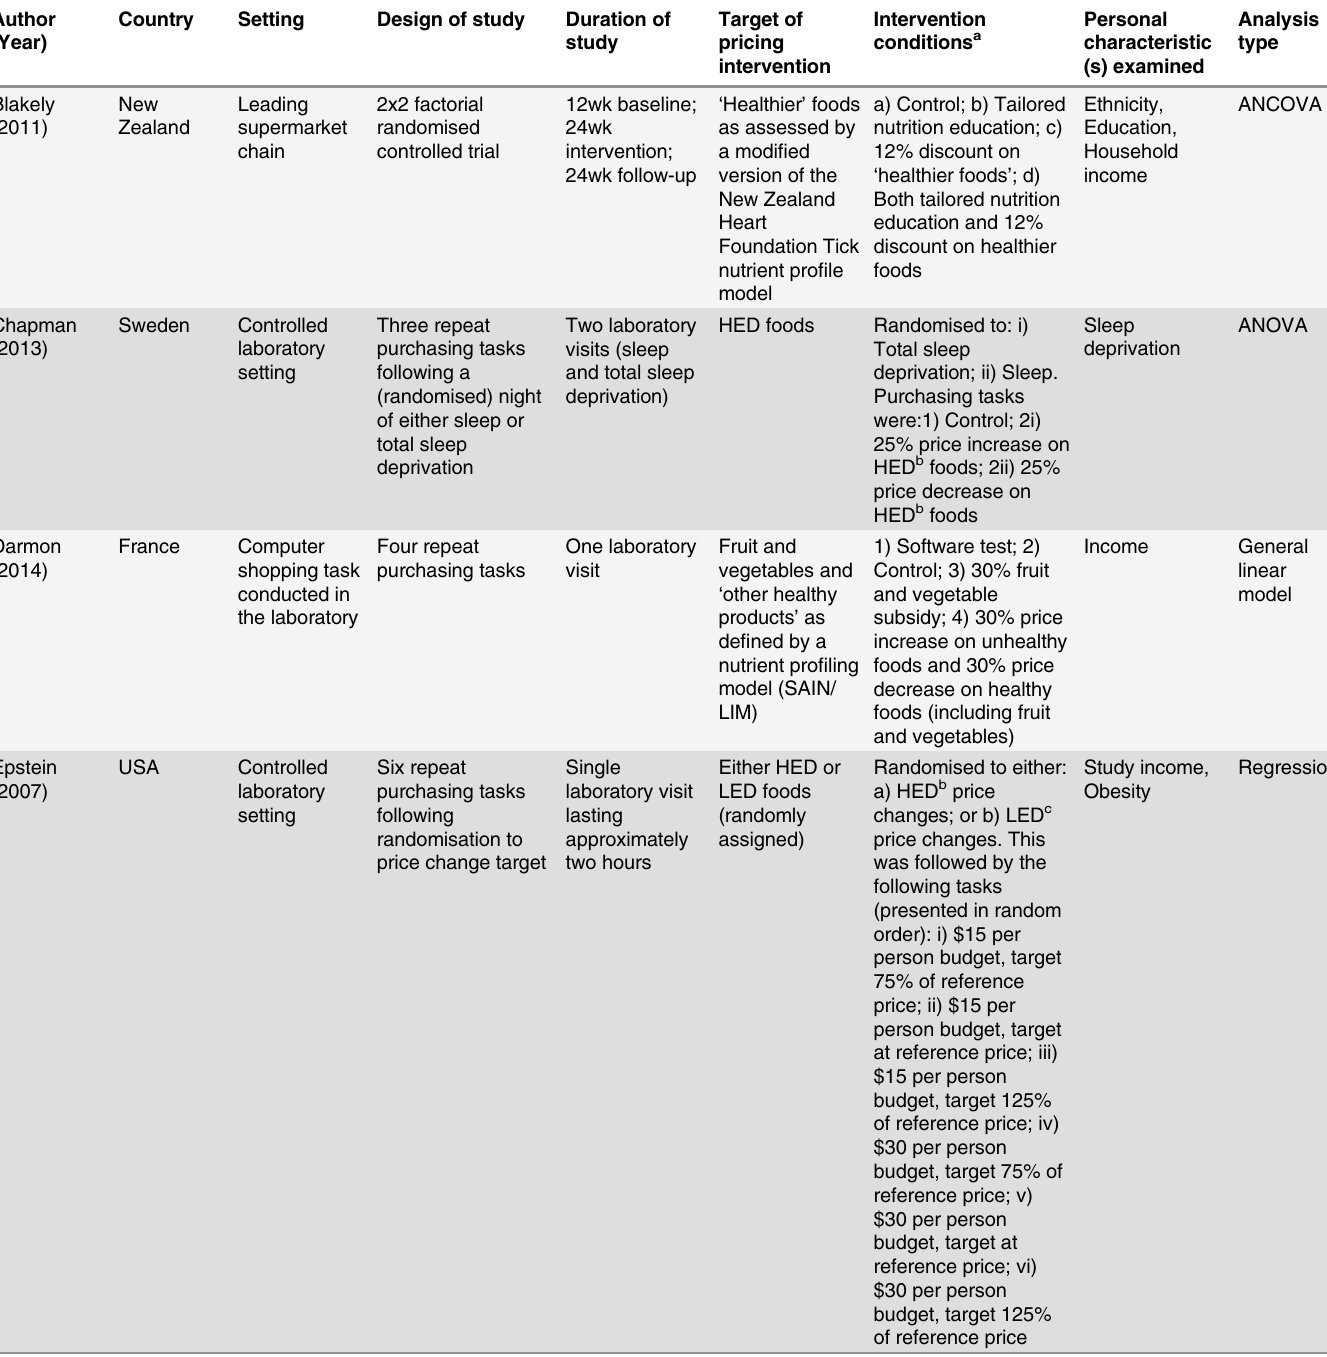
Table 2. Summary of included